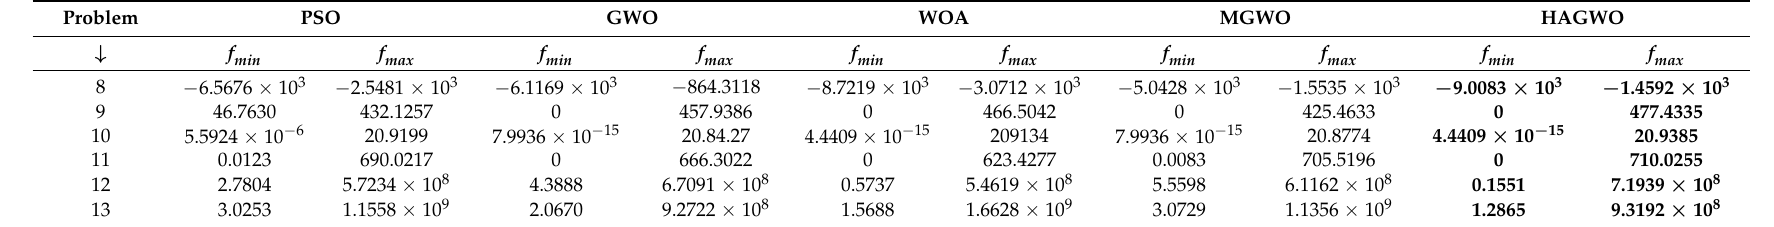
Table 6. Numerical results of multimodal benchmark